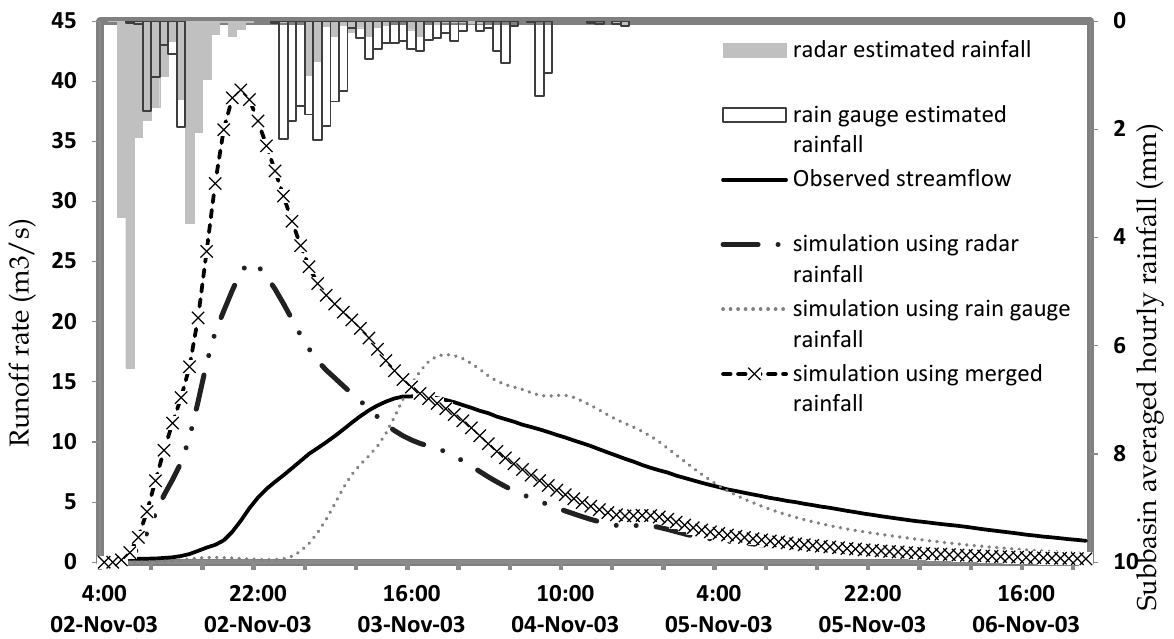
Figure 16. Comparison of estimated and observed hydrographs using different rainfall estimates for the 2 November 2003 event with SCS modeling option.